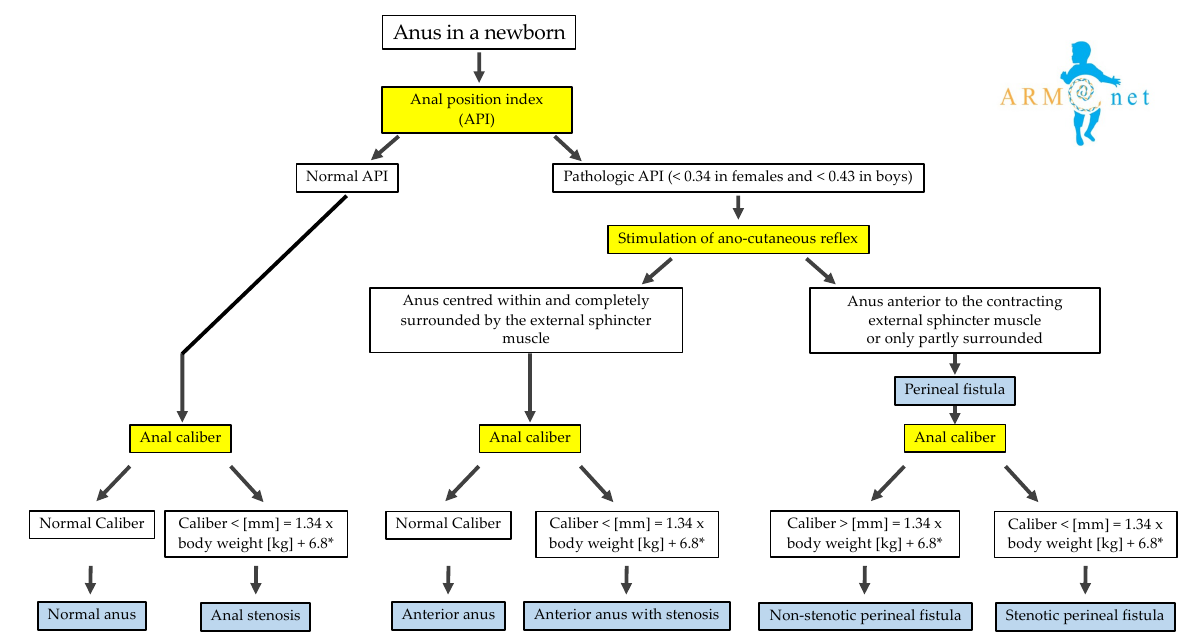
Figure 2. The algorithm shows the diagnostic pathway that leads to diagnosing a normal anus, anterior anus with or without stenosis, congenital anal stenosis, and perineal fistula (stenotic or non-stenotic). * The anal caliber is measured according to the equation presented by el Haddad and Corkery